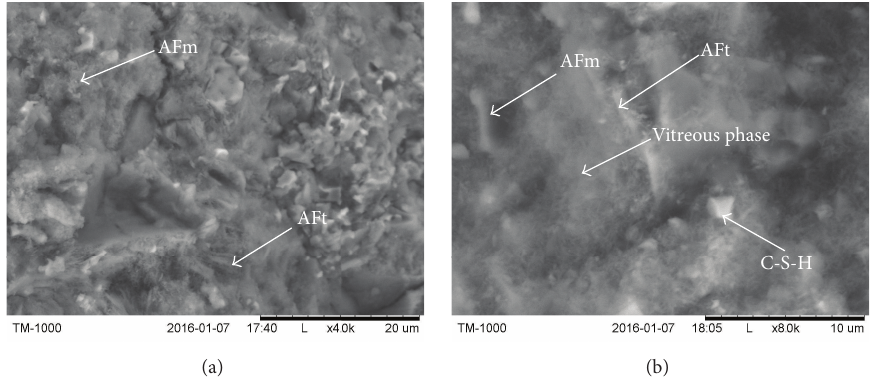
Figure 14: SEM of cement paste (a) without NS and (b) with NS30/4.0 at 3